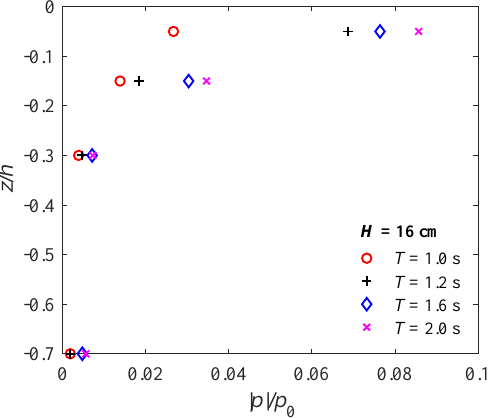
Figure 9. Distribution of the maximum pore-water pressure vs soil depth ( z ) in front of the pile for various wave periods ( x = 0.15 m, H = 16 cm, Points 11, 12, 13, and 5).